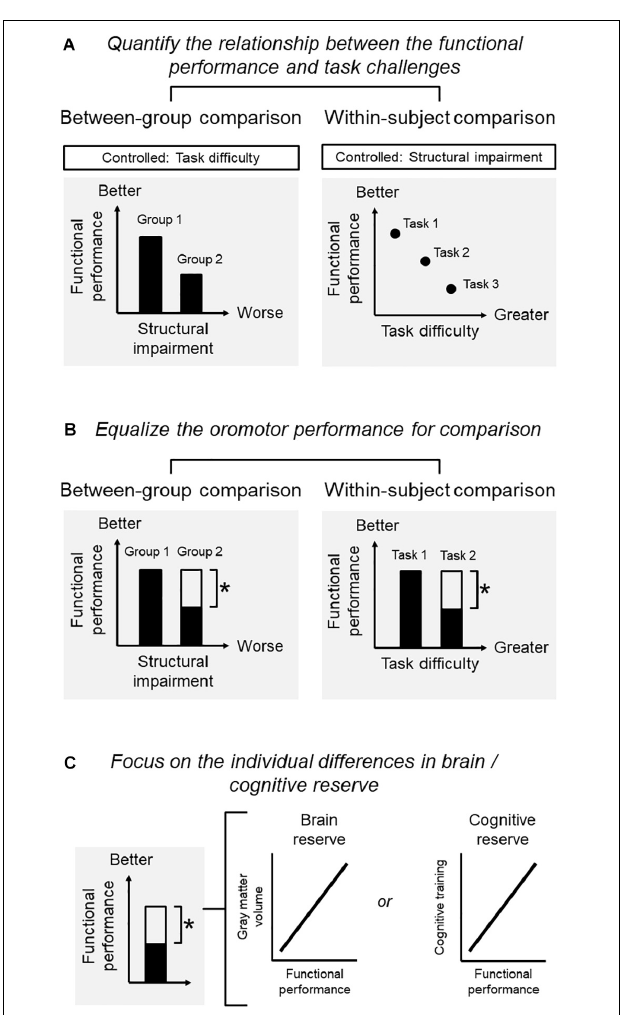
FIGURE 1 | Conditions for a study on the adaptation of oromotor functions. (A) Quantify the relationship between functional performance and challenges: functional performance, structural impairment, and task difficulties may interact with each other so that one factor needs to be controlled when the other two are investigated. For example, when adopting a between-group comparison, one may be interested in the performance associated with structural impairment. The task for assessing the performance should be controlled. When adopting a within-subject comparison, one may be interested in the performance for the same subject under different levels of task difficulty. The degree of structural deficits should then be controlled. (B) Equalize the oromotor performance for comparison): for a within-subject design, it is critical to define the degree of functional adaptation that should ideally bring the individual back to the original level (before diseases) or, at least, to an acceptable level whereby the individual can perform daily functions satisfactorily. For a between-group comparison, one would focus on the contrast between two groups with different degrees of structural impairment, yet showing the same degree of functional performance. (C) Focus on the individual differences in brain/cognitive reserve: in older people, a sufficient brain and cognitive reserve would be necessary for them to develop better compensations against impairment increased performance. Without clarifying the brain-performance relationship, the identified changes in brain signatures merely represent an age-related phenomenon. One would expect that the degree of functional performance in the adapted group (i.e., the group with structural impairment yet showing an adequate performance) to be correlated with the brain